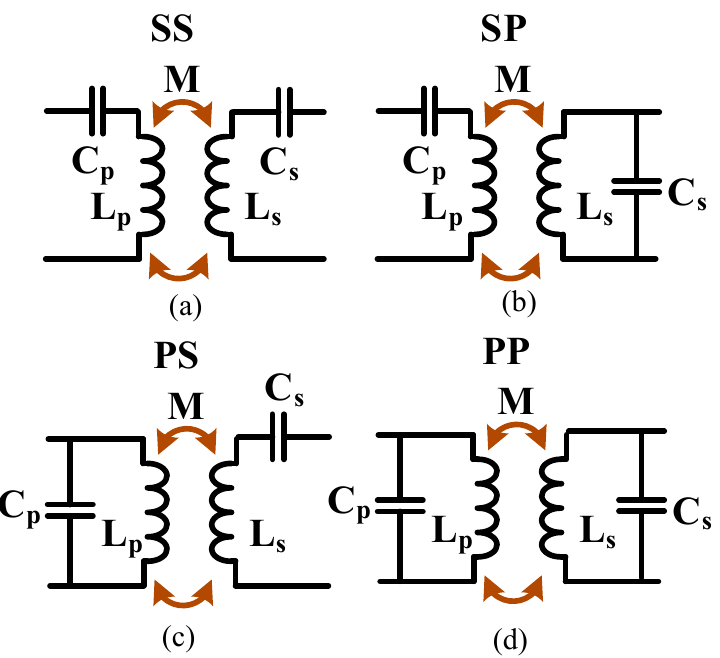
Figure 3. Compensation networks ( a ) SS; ( b ) SP; ( c ) PS; ( d ) PP.